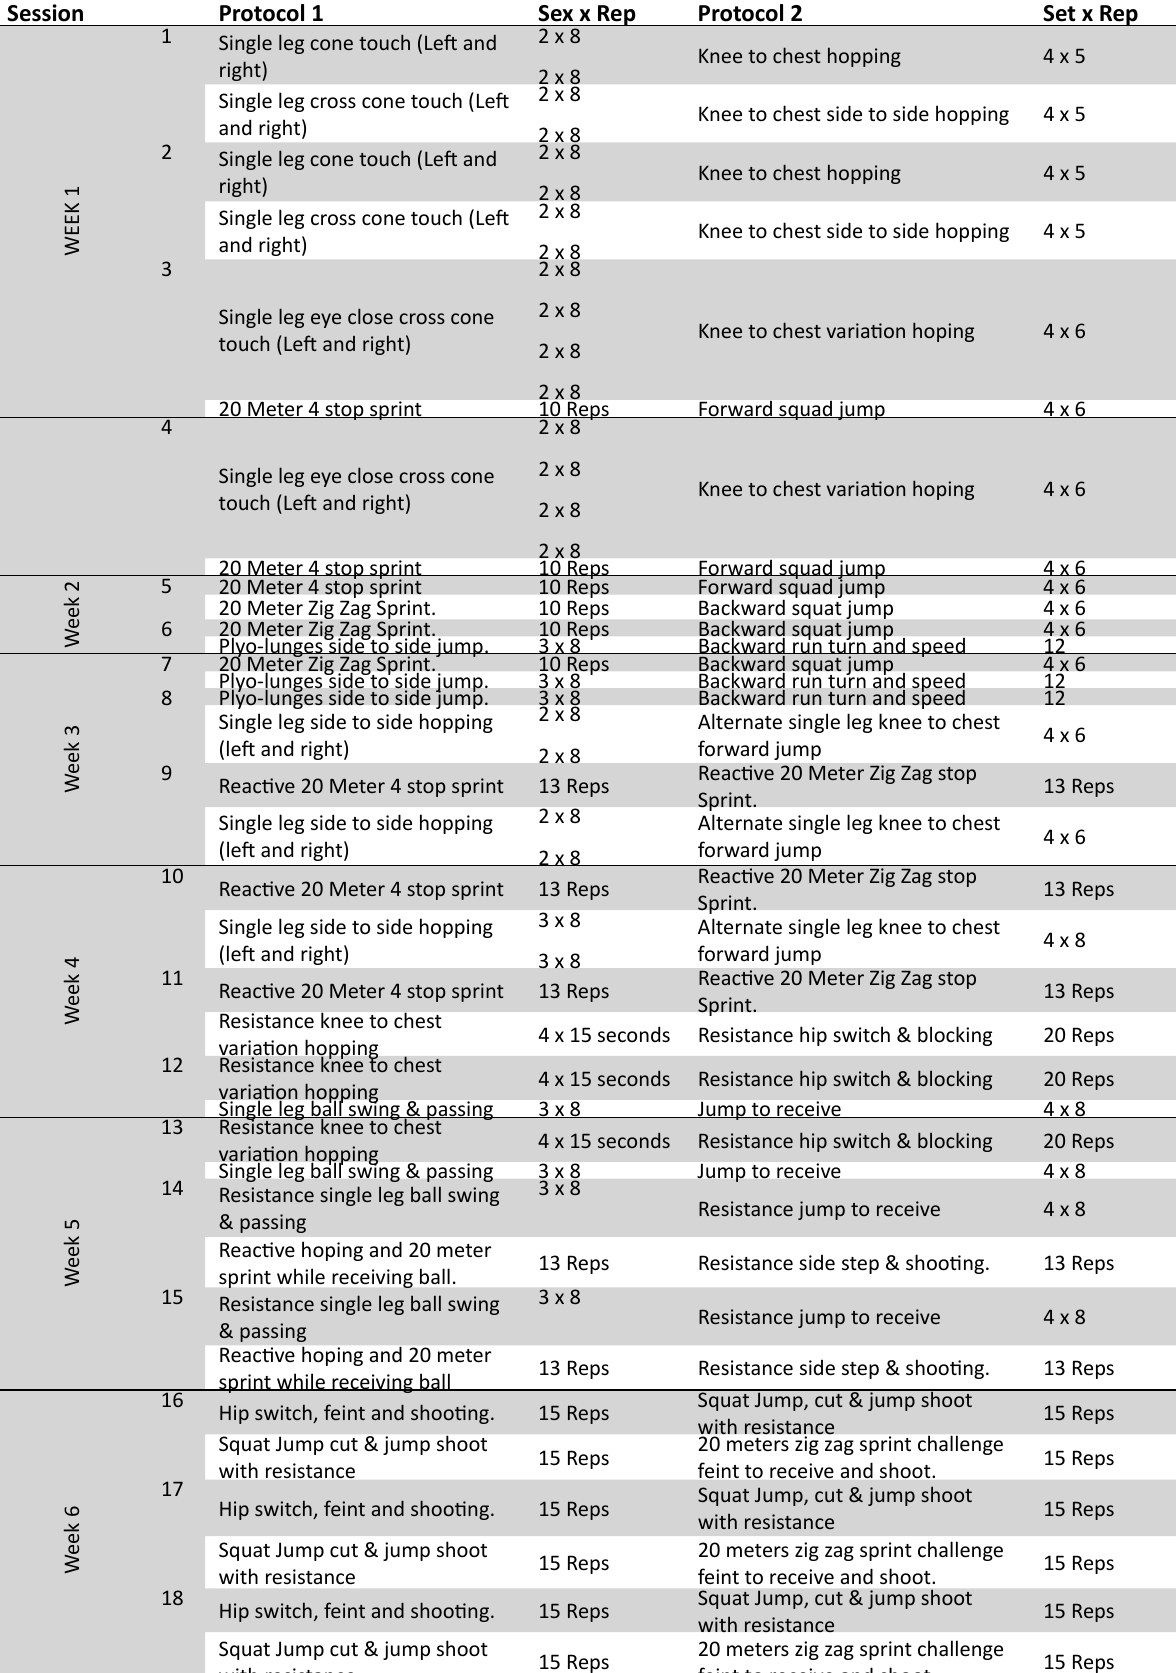
Table 2. Coordination, Dynamic balance and Agility Intervention (CoBAgi Protocol)